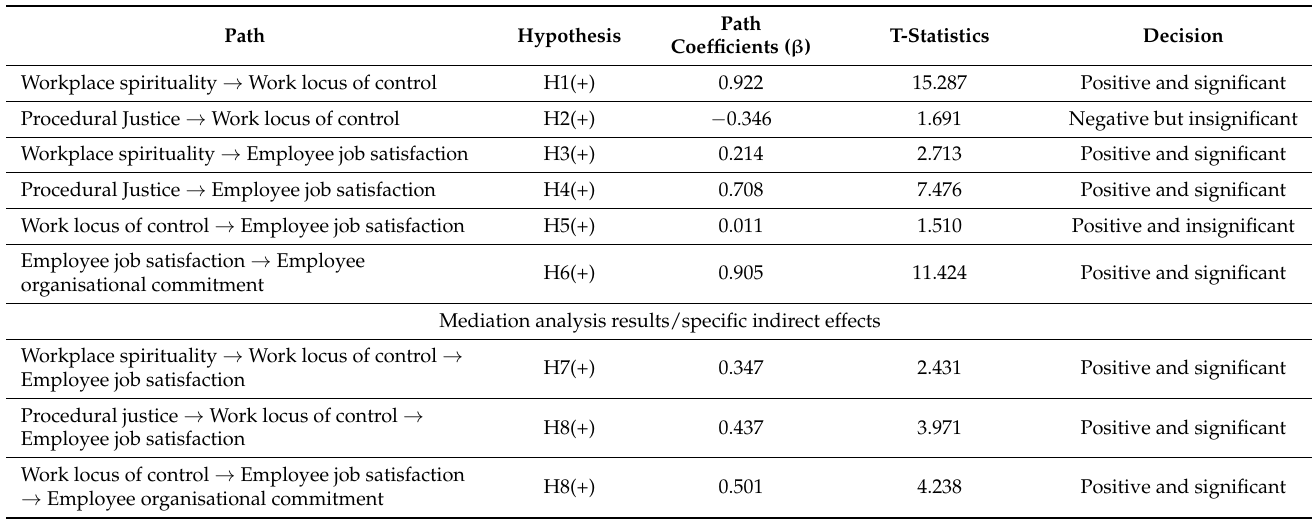
Table 4. Results of structural equation model